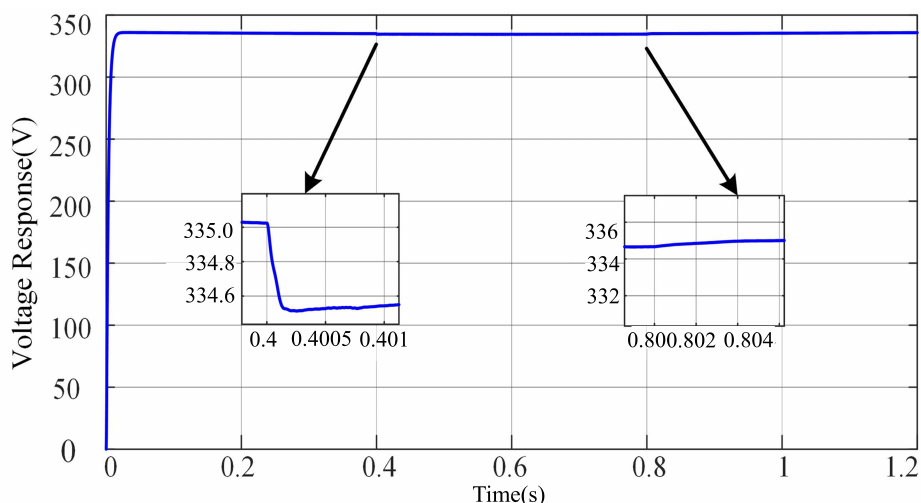
Figure 21. Output voltage response during the transition process.